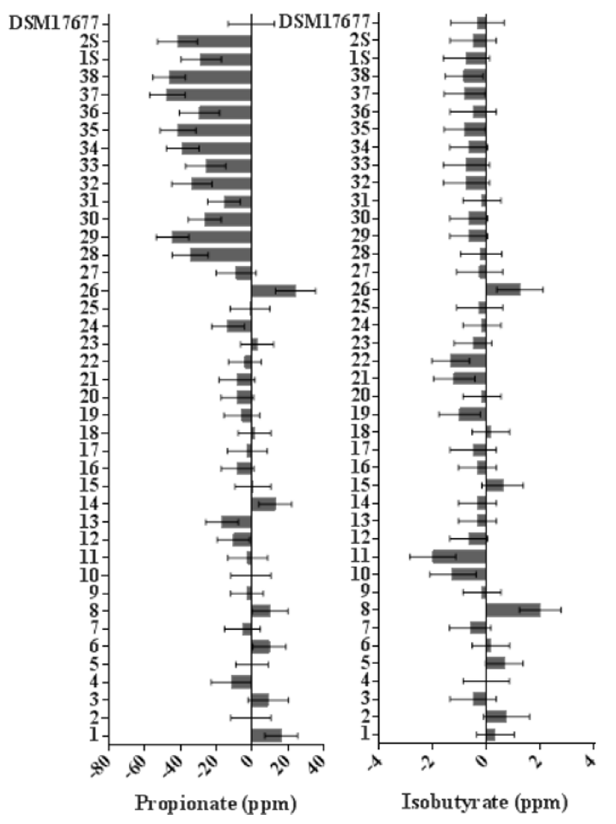
Fig. 3. Average difference of propionate and isobutyrate concentrations in the growth media after 48 h of incubation of each F. prausnitzii isolate. The bars represent the mean concentration in ppm. Error bars indicate the standard error of the